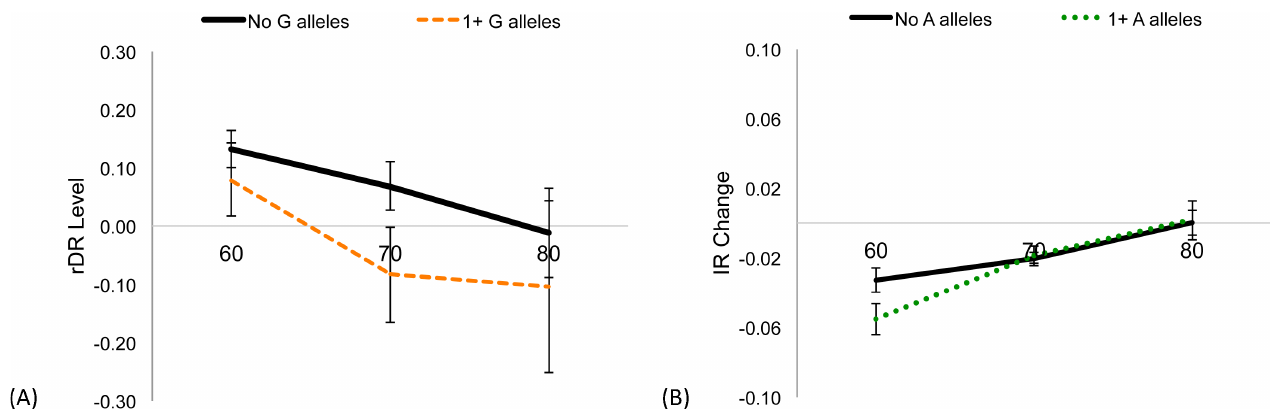
Fig 6. Plot of effect sizes of top TOMM40 risk alleles against age, adjusted for APOE e4 presence. (A) Effect of the G allelein rs2075650on rDR-L and (B) Effect of the A allelein rs157582on IR-C. The lines representage-related trajectories of the phenotypefor individuals who have no risk alleles(solid line) or 1 or more risk